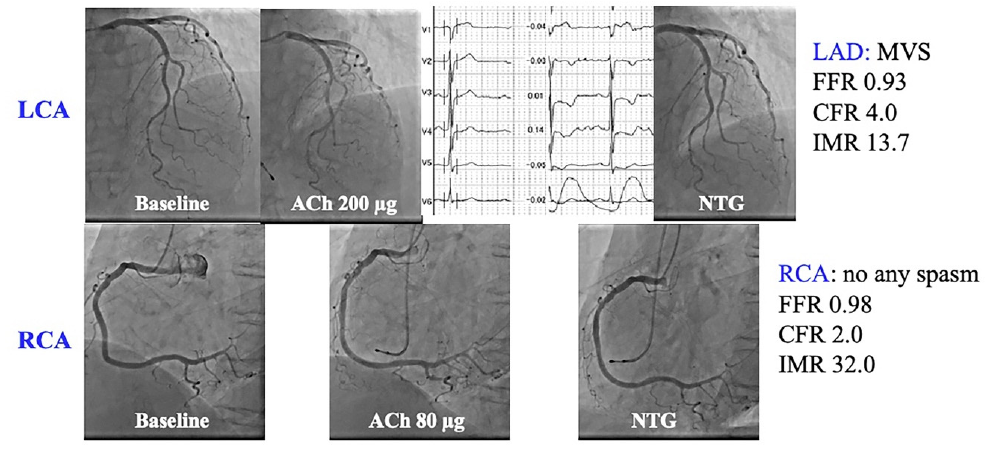
Figure 4. A representative case (Case 11 in Table 4). A 79-year-old woman complained of chest pain at rest. LAD SPT revealed no induc- tions of epicardial coronary spasm (upper panels). With chest pain and precordial in- verted T waves during SPT in the LAD, MVS was considered in the LAD. Contrarily, the SPT for the RCA showed no inductions of angiographic and electrocardiographic changes. The MVFT revealed normal CFR and IMR in the LAD with MVS. There was reduced CFR and increased IMR in the RCA without any types of spasm. This patient might have dif- ferent MVFs in the RCA and LAD. CFR, coronary flow reserve; IMR, index of microcirculatory resistance; MVF, micro- vascular vasodilatory function; MVFT, microvascular vasodilatory function test; MVS, microvascular spasm; SPT, spasm provocation test. 4. Discussion In this study, we investigated MVF in patients who underwent SPT and MCFT to evaluate their chest symptoms. We found that (1) smoking status, especially active smok- ing may increase IMR; (2) the focal spasm type and RCA may affect IMR and (3) the base- line Pd/Pa, FFR and IMR in the RCA were higher than those in the LAD, although the CFR did not significantly differ between the two vessels. Factors such as ageing, smoking, hypertension, dyslipidaemia and diabetes mellitus are associated with MVD [5,7–10]. In this study, smoking status, especially active smok- ing, was associated with an increased IMR, which is in agreement with the results of other studies [7,9]. However, other factors were not associated with the MVFT data. In general, smoking has been known to increase oxidative stress, leading to vascular inflammation, impaired prostacyclin production, and vascular dysfunction [29,30]. Moreover, 60% of our patients had VSA, and smoking is one of the major risk factors for VSA [31]. This population and the small sample size may have contributed to the slight difference in the results. In addition, since this study was cross-sectional, it is unclear from the results whether smoking cessation improves MVD. However, considering the fact that there was no significant difference in the MVFT data between former smokers and never smokers, smoking cessation may be a valuable treatment for MVD. The present study demonstrated that the IMR value in the RCA was higher than that in the LAD, which is in agreement with the results reported by Murai et al. [10]. They speculated that the spatial heterogeneity of myocardial flow in different vascular beds